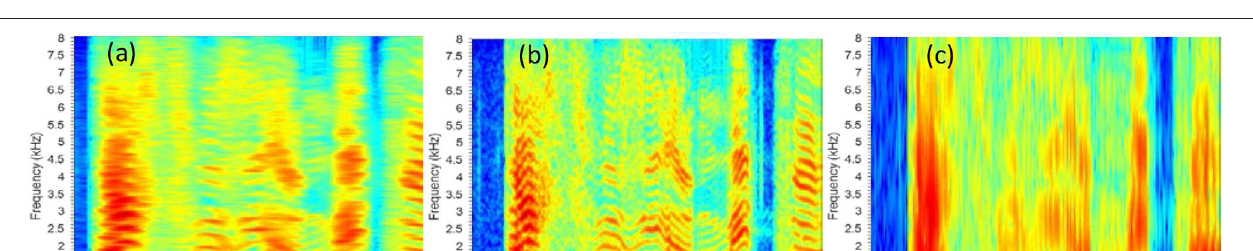
FIGURE 3 | Generation of spectrogram magnitude arrays.